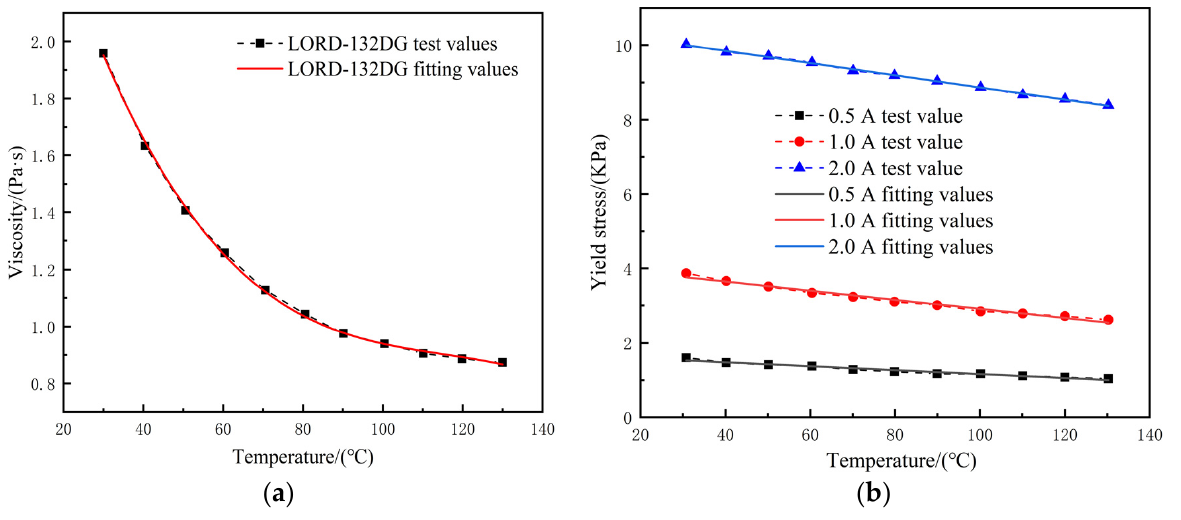
Figure 4. Influence of temperature on viscosity and yield stress of Magnetorheological Fluid. ( a ) Influence of temperature on the viscosity of Magnetorheological Fluid; ( b ) effect of temperature on yield stress of Magnetorheological Fluid.